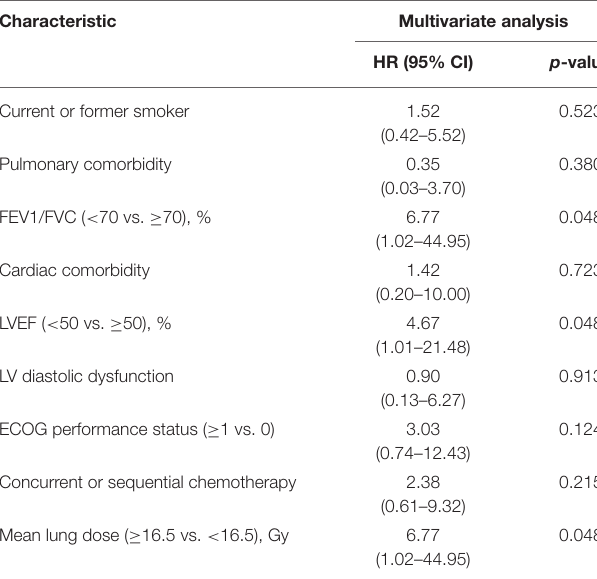
TABLE 4 | Multivariate logistic regressions analysis of grade ≥ 2 radiation pneumonitis for patients with baseline dyspnea =